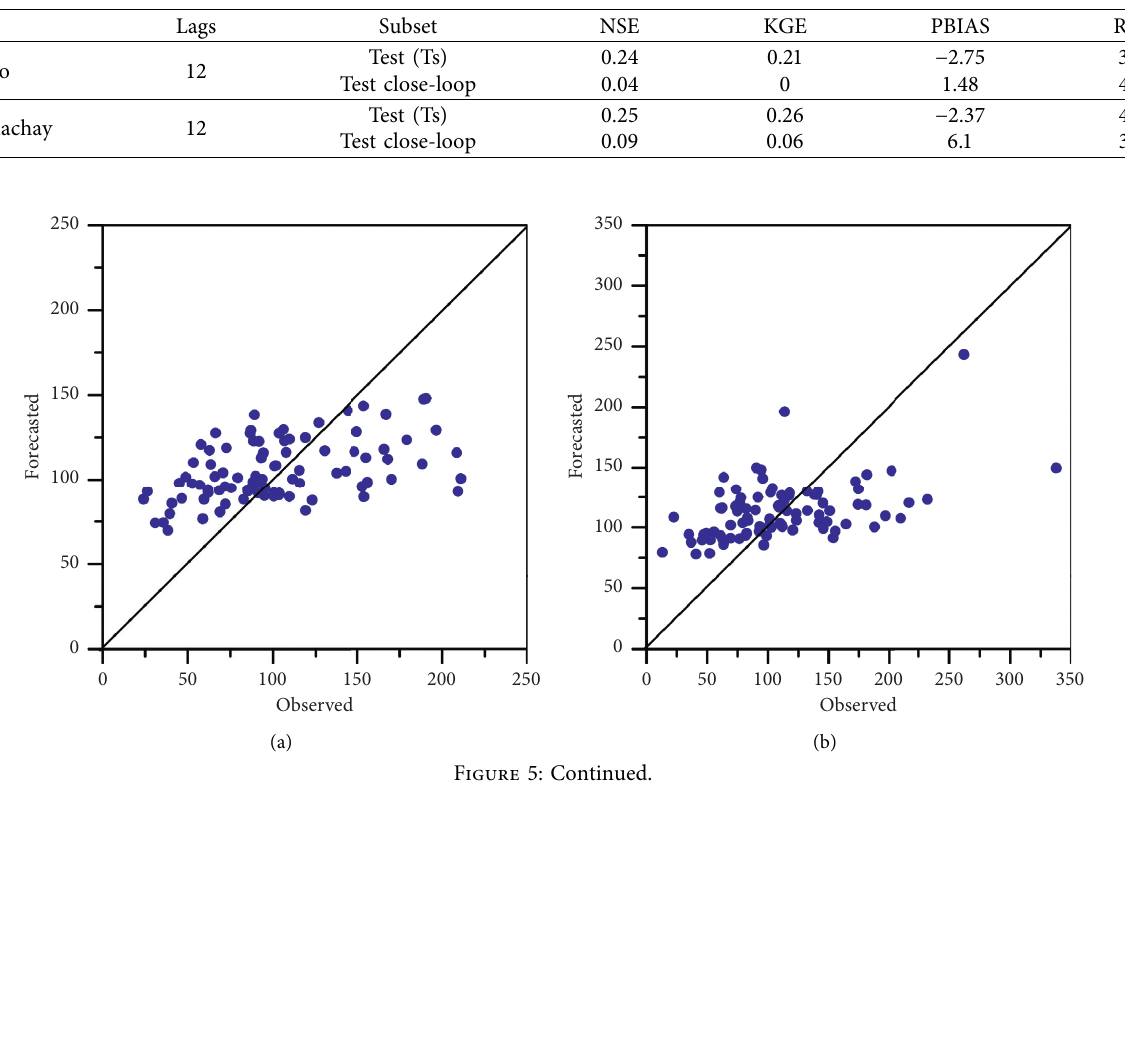
Figure 4: NSE metric for models obtained by ridge regression and lasso: (a) Labrado; (b) Chirimachay. Table 3: Results for RF models.